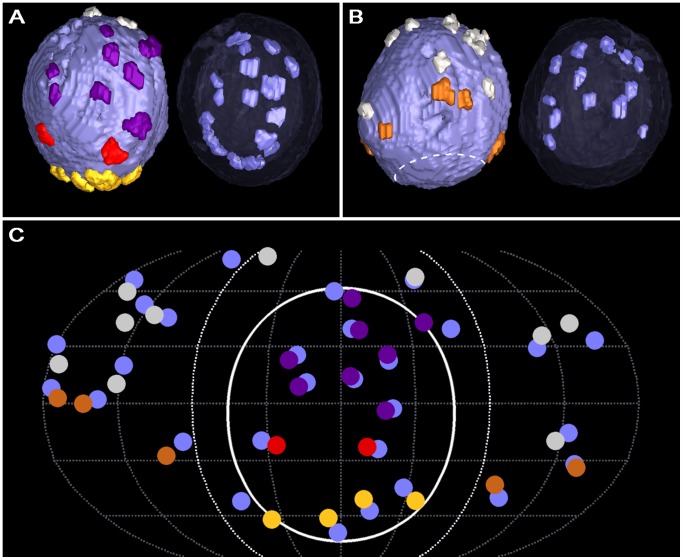
Pairing of connection sites of nubs with connection sites of AZM and non-AZM macromolecules.(A,B) Surface model of the membrane of a docked vesicle in one of the primary reconstructions; (A) shows the hemisphere facing the main body of the AZM and (B) shows the hemisphere facing away from the main body. (A-left, B-left) Three-voxel-thick terminal portions of the AZM’s ribs (gold), spars (red), booms (purple) and pins (copper) and of non-AZM macromolecules (pewter), mark the connection site of each on the outer cytosolic surface of the vesicle membrane (pale blue). The vesicle’s fusion domain is indicated by the dashed line (B). (A-right, B-right) The AZM and non-AZM macromolecules are disabled on the surface model and the membrane has been made almost transparent. Three-voxel-thick terminal portions of the luminal assembly’s nubs (blue) mark the connection site of each on the luminal surface of the vesicle membrane. The distribution of the connection sites of the nubs is non-uniform and appears similar to the asymmetric distribution of the connection sites of the AZM and non-AZM macromolecules, although some of the similarity is obscured in these 2D images by the vesicle’s 3D curvature and the difference in the vesicle’s luminal and outer diameters. (C) Using x,y,z coordinates of the connection sites in (A,B), after correcting for the difference between luminal and outer diameters of the vesicle membrane, the relative positions of the centroids of the connection sites of the AZM and non-AZM macromolecules and of the nubs were plotted on a 2D Robinson map. The centroids were overlaid by filled circles slightly smaller in diameter than the connection sites and color-coded as in (A,B). The hemisphere of the vesicle facing the main body of the AZM lies between the bold longitudinal lines. The main AZM binding domain, which covers about 20% of the outer surface area of this vesicle and includes about half of the total nub and AZM/non-AZM macromolecule connection sites on the membrane, is encircled by the solid white line. Each nub is paired with an AZM or non-AZM macromolecule lying opposite to, or slightly offset from, it.